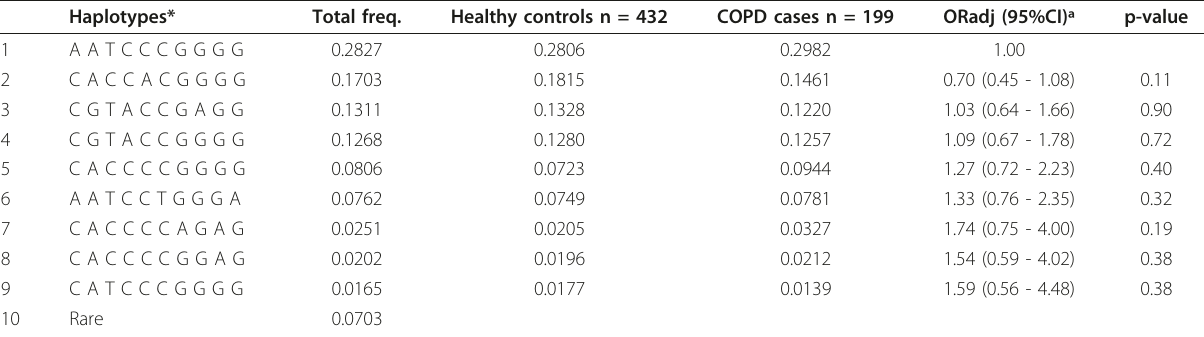
Table 5 Haplotype frequency of the LTA and TNFA genes SNPs in COPD patients vs. Healthy control individuals